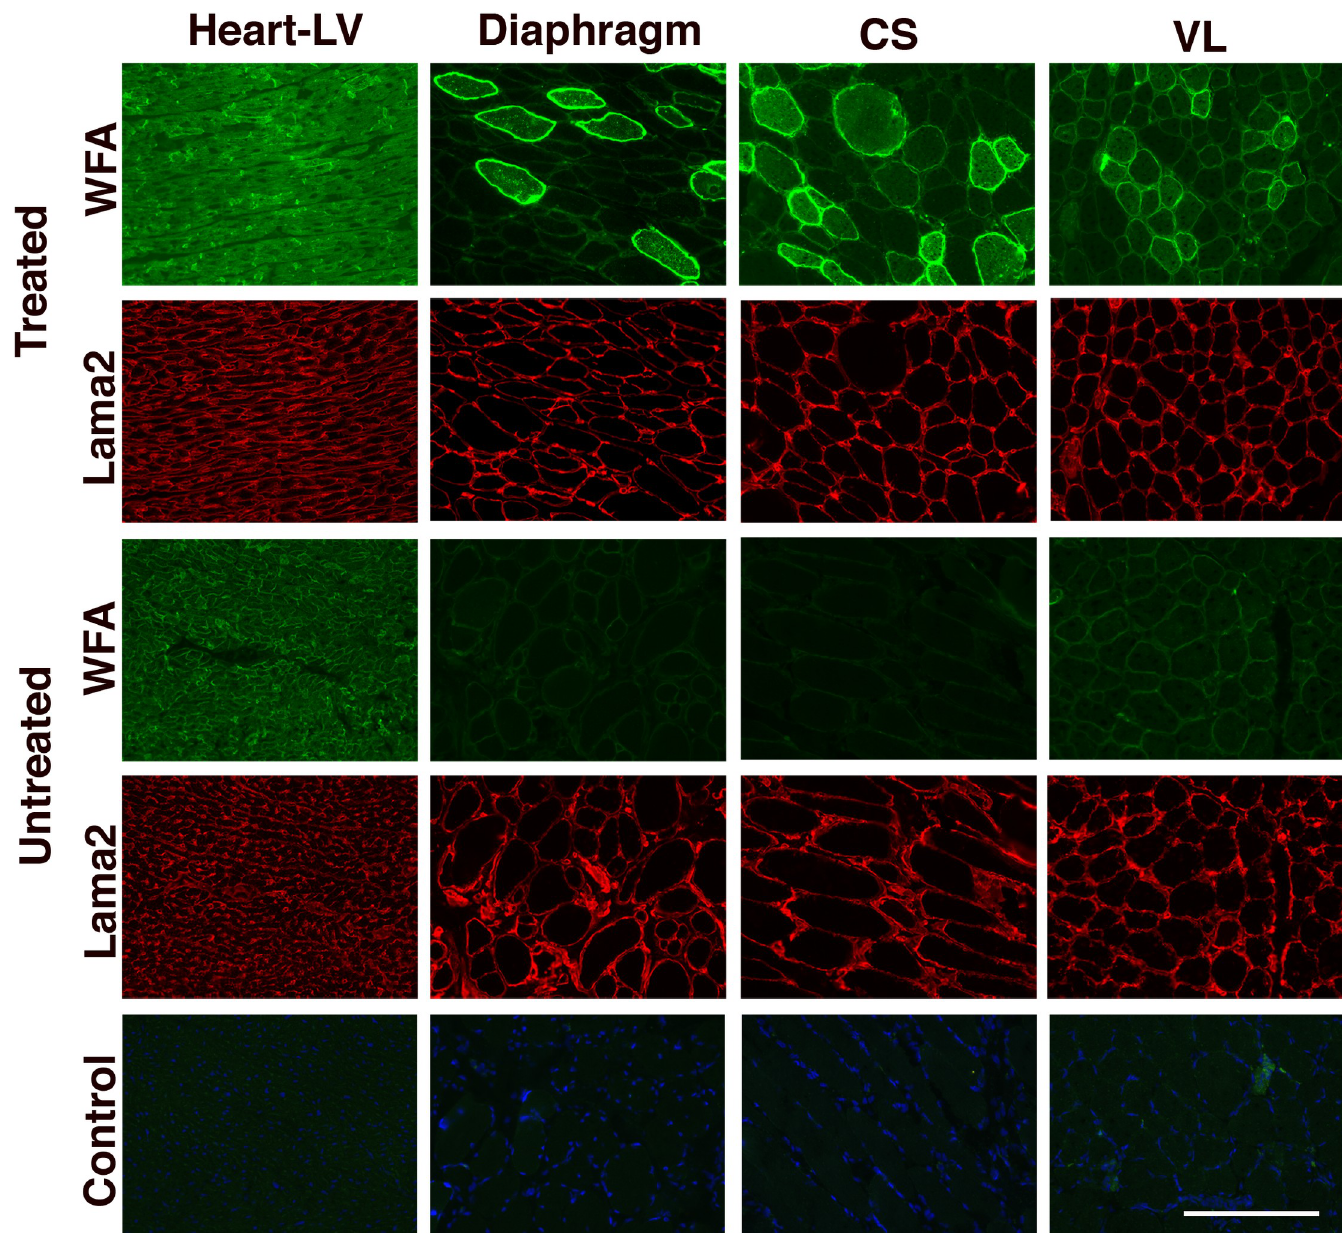
Fig 3. WFA staining after treatment of GRMD dogs with rAAVh74.MHCK7. GALGT2 . Muscle sections from 6-month-old GRMD dogs treated (or untreated) at 3 months of age with 2x10 14 vg/kg of rAAVrh74.MHCK7. GALGT2 were assayed for GALGT2 -induced glycosylation. Sections were stained with WFA (green), to identify β GalNAc made by GALGT2, and with antibody to laminin α 2 (Lama2, red), to identify sarcolemmal membranes. Control shows merged red, green and blue fluorescence signal without WFA and with only secondary antibody, with DAPI (blue) added as a nuclear co-stain. Sections were stained from heart (left ventricle, LV), diaphragm, cranial sartorius (CS), and vastus lateralis (VL). All exposures are time matched. Bar is 100 μ m for all panels. diaphragm, deep pectoral, and medial head of the gastrocnemius showed about 50% of skeletal myofibers with increased WFA staining, comparable or higher than levels seen with the lower dose. The majority of skeletal muscles studied, however, did not show a clear increase in glyco- sylation at the higher dose, suggesting either a kinetic hindrance to achieving higher glycosyla- tion or a saturation of glycosylation at the lower dose.